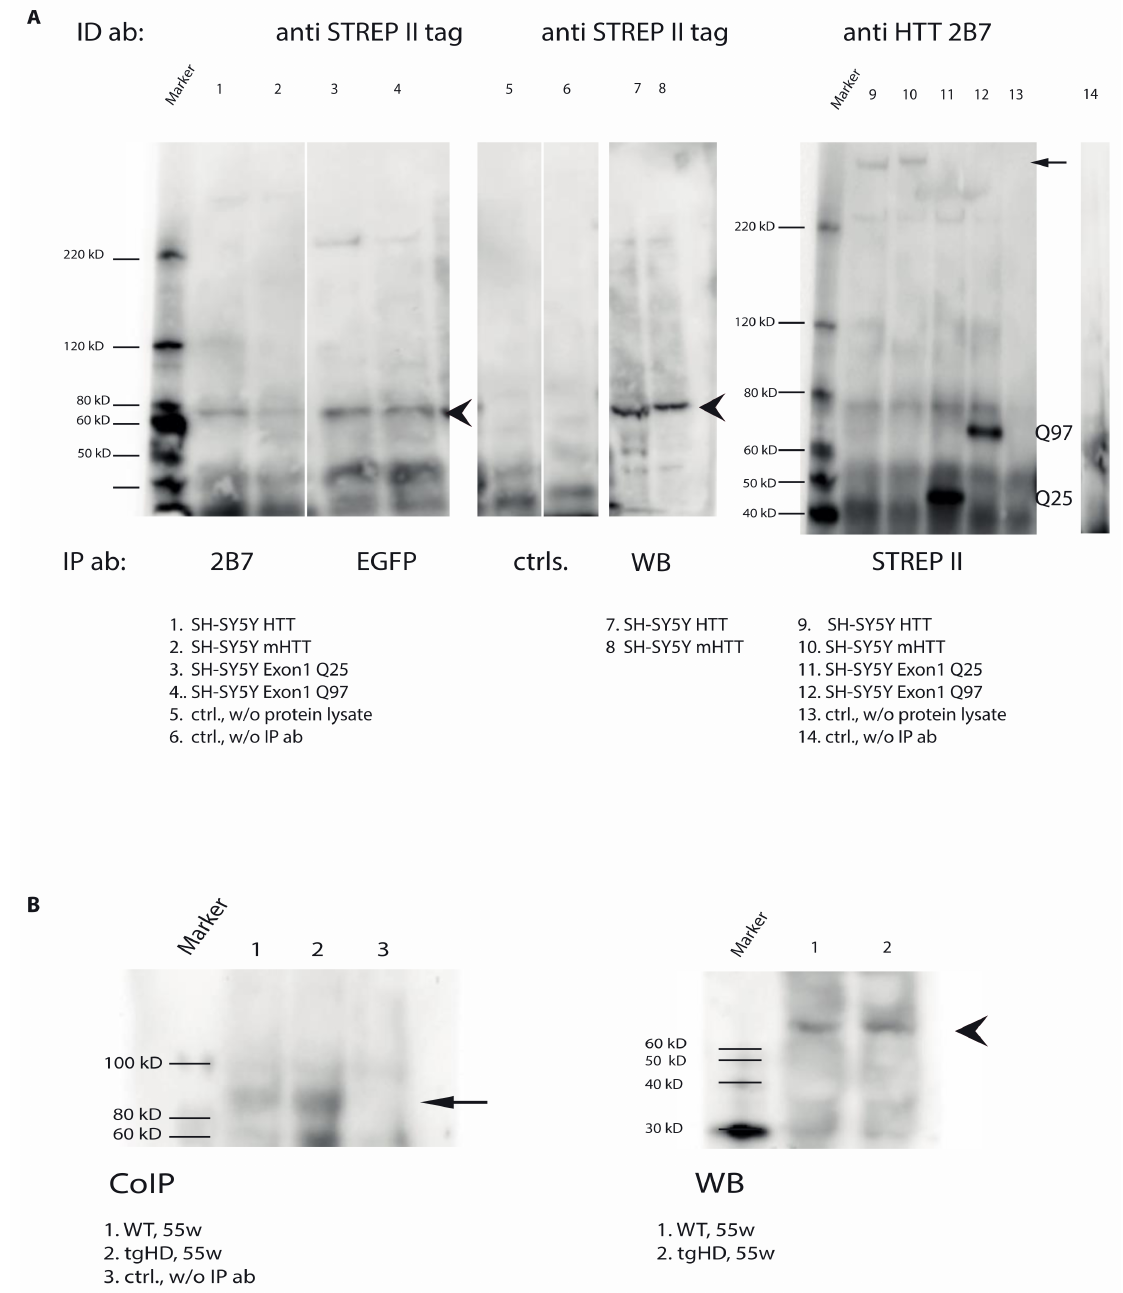
Figure 6. Direct interaction of TG6 and (m)huntingtin. ( A ) For interaction analysis of (m)HTT and exon1 fragments with TG6, protein fractions of transiently transfected SH-SY5Y cells, expressing either full-length (m)HTT or exon1 fragments with either a normal (25 polyglutamines) or mutated (97 polyglutamines) CAG repeat connected to a C-terminal EGFP were used. Anti-Strep II antibody was used for the identification of TG6. ( B ) TG6 was co-immunoprecipitated from the soluble fractions of both wt and tgHD rats (arrow). Brain protein lysates of wild type and tgHD rats (55 weeks-old) were used and (m)HTT was precipitated using a (m)HTT-specific antibody (mab2166, MerckMillipore, Darmstadt, Germany; 1 µ g). For the detection of TG6, a polyclonal isoform-specific antibody (Zedira, Darmstadt, Germany) was used. The Clean-Blot IP Detection reagent (Thermo Scientific, Waltham, MA; USA), coupled to HRP, was used to reduce interference from denatured IgG background signal. The TG6 protein displayed the expected molecular weight of about 79 kDa when analyzed by Western blot (WB,